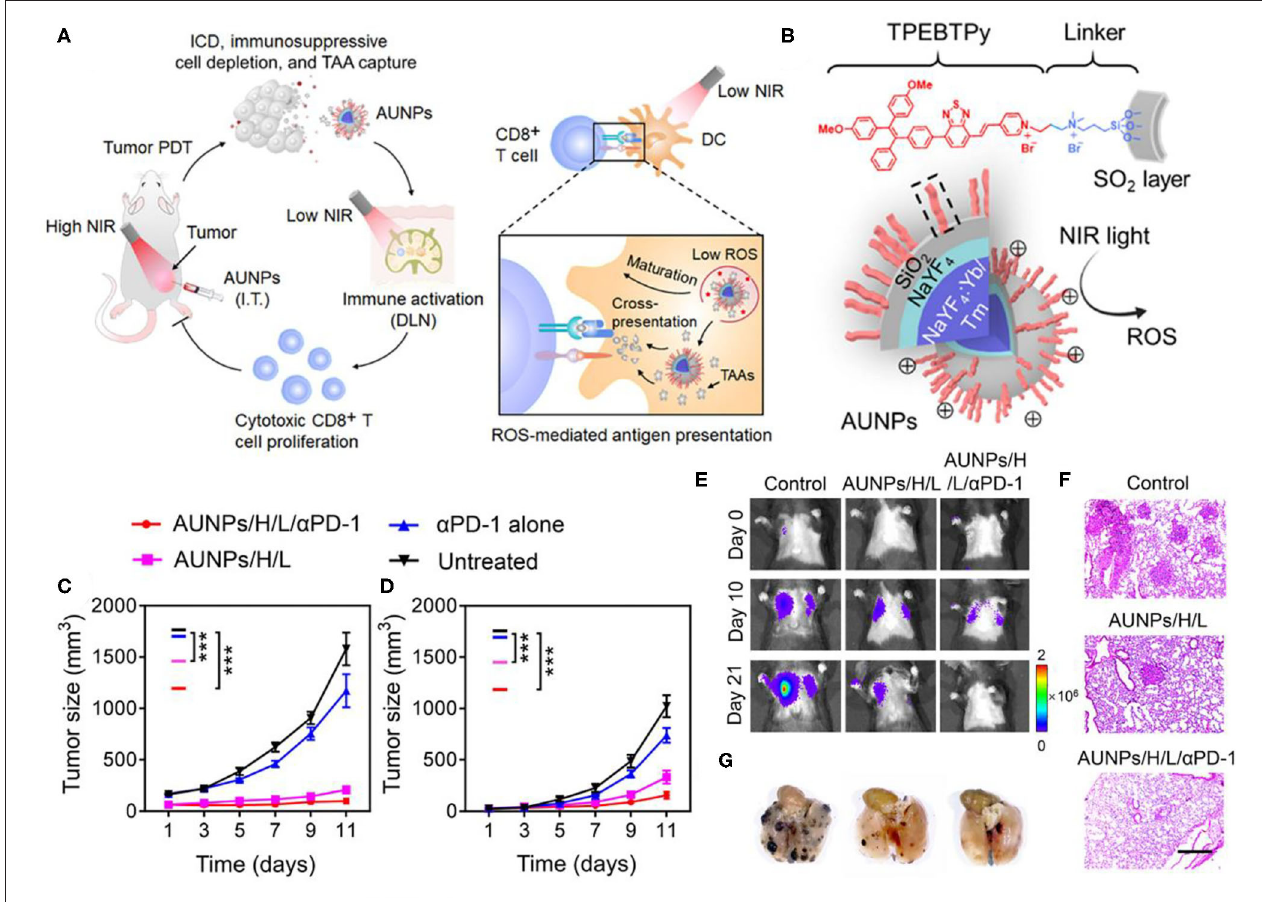
FIGURE 8 | (A) Proposed scheme of dual-mode ROS-driven tumor immunotherapy. (B) Structure of TPEBTPy and AUNPs. Dashed box indicates a linked TPEBTPy molecule on the AUNPs. (C) Primary and (D) distant tumor growth curves of the B16F10 tumor–bearing mice with different treatments ( n = 5). (E) Bioluminescence images of mice after rechallenging with intravenous injection of B16F10 tumor cells. (F) Representative lung photographs (21 days) and (G) hematoxylin and eosin (F&G) images of lung tissue slices from control (naïve mice), AUNPs/H/L, and AUNPs/H/L/ α PD-1 groups. Scale bar, 100 µ m. Copyright 2020, American Association for the Advancement of Science ( Mao et al., 2020). * P < 0.05, ** P < 0.01, and *** P <